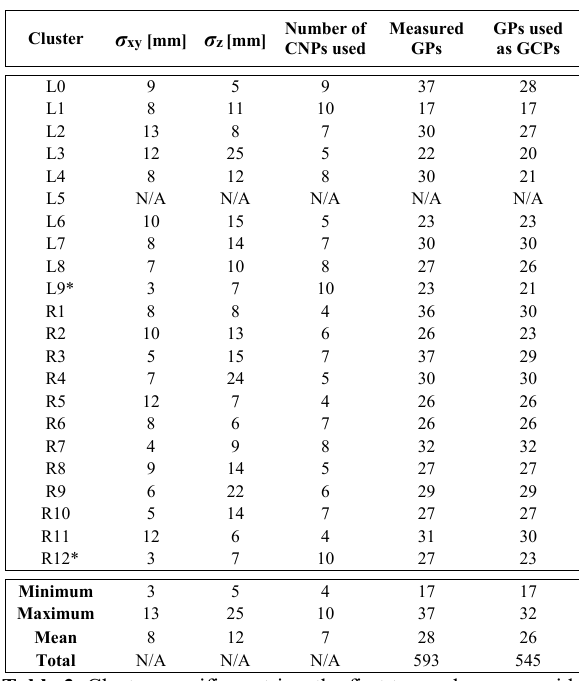
Table 3 . Cluster-specific metrics: the first two columns provide precision metrics for the derived TS16 centres, computed using the number of CNPs in column three. The last two columns give the number of measured GPs and used GCPs (Graffiti-scape Control Points are GPs that constrain the bundle adjustment). *Observed from the same total station position. Table 4 . Accuracy metrics for the oriented image